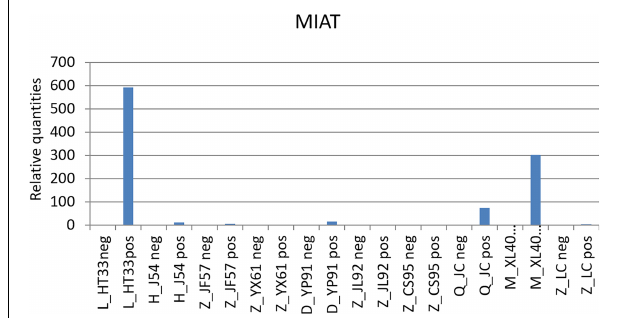
FIGURE 12 | qPCR results of MIAT. MIAT was upregulated in the patients with MM. According to the original detection results of RT-PCR, and the relative quantities was calculated by 2– (cid:77)(cid:77) ct, the difference of the transcription level of MIAT of each sample was calculated. The ordinate is the relative expression of MIAT in MM.